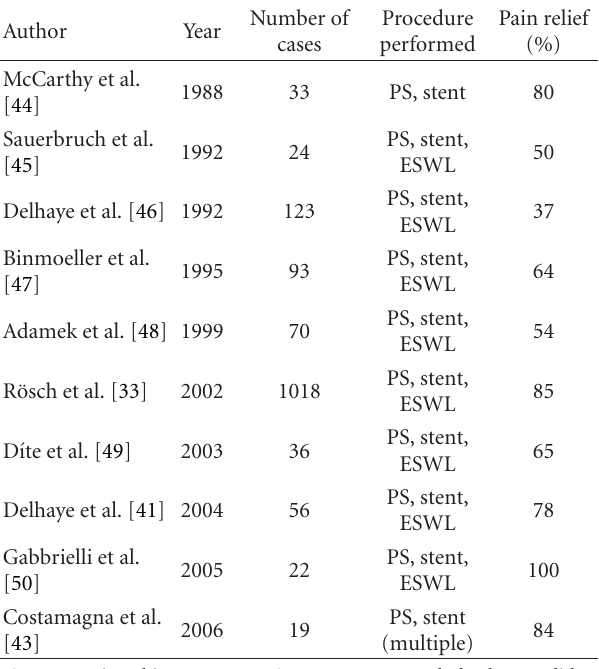
Table 2: Selected studies on pain relief with pancreatic endother-